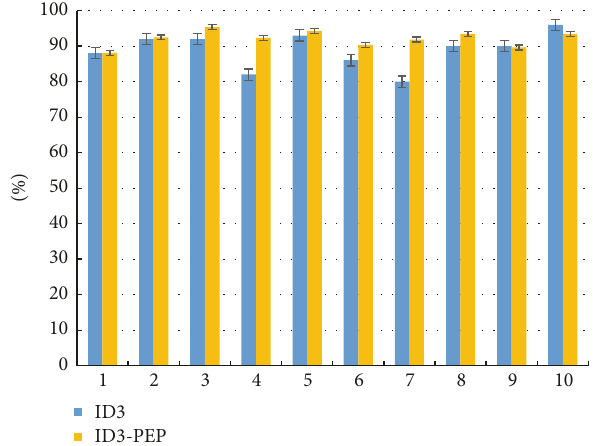
Figure 5: Comparison of two classification algorithm (the blue credibility refers to the classification accuracy by ID3 algorithm, and the yellow credibility refers to the classification accuracy by ID3 decision tree algorithm with PEP).